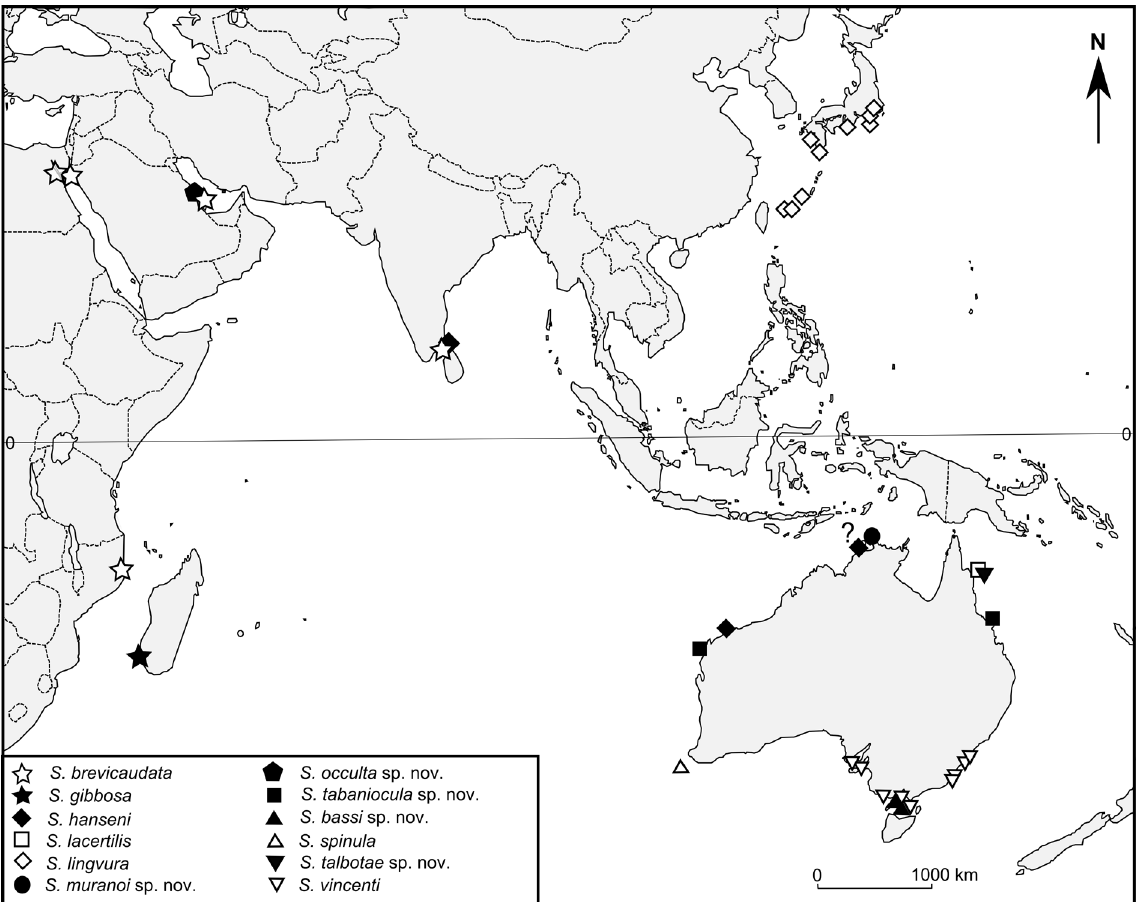
Fig. 1. Distribution of species in the Siriella brevicaudata species group. Question mark (?) indicates published record requires